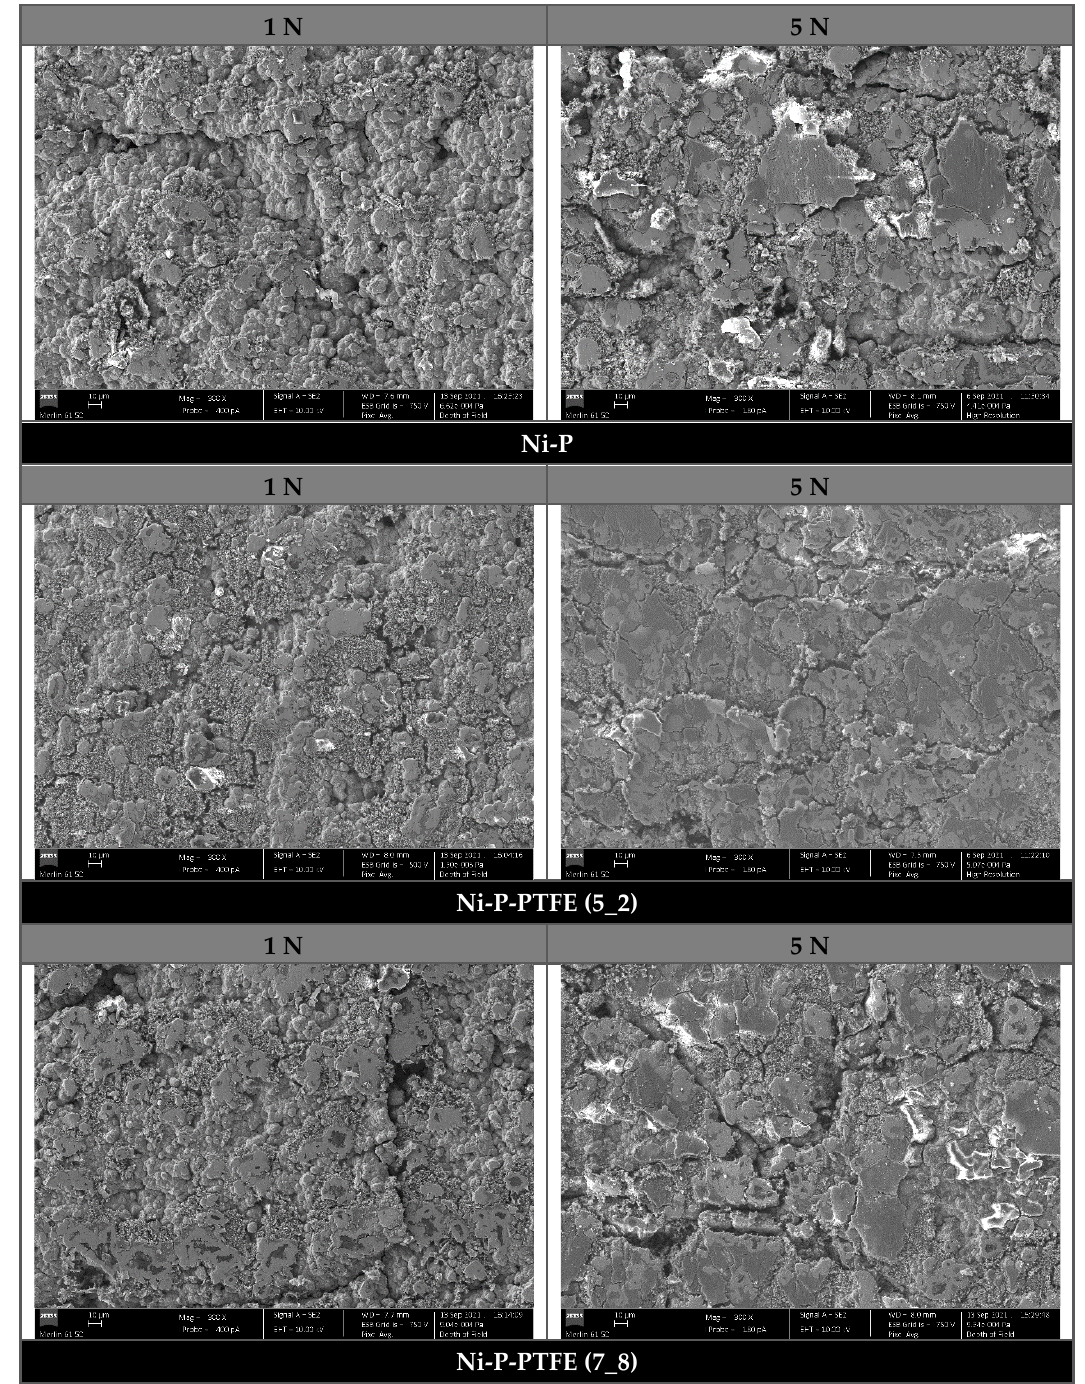
Figure 7. SEM micrographs of wear tacks of Ni-P and Ni-P-PTFE films on rPDA-NBR at 300× magnification.